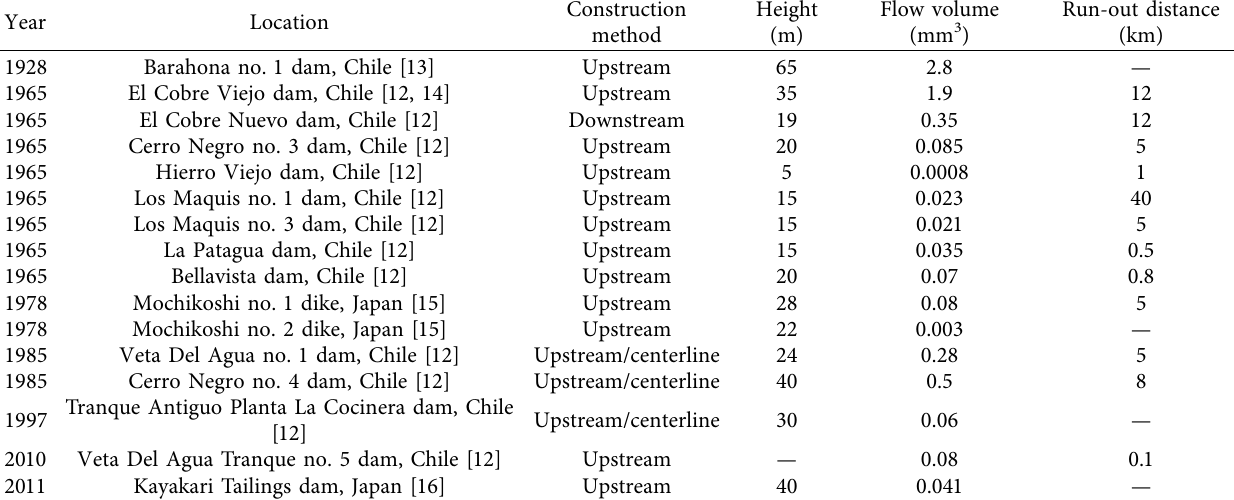
Table 1: Summary of the case histories of earthquake-induced failures of tailings